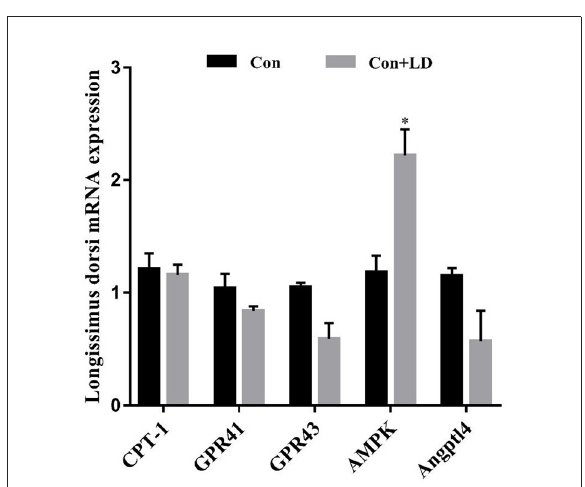
TABLE 4 Effects of L. delbrueckii on hepatic enzyme activity related to fat metabolism of growing-finishing pigs.